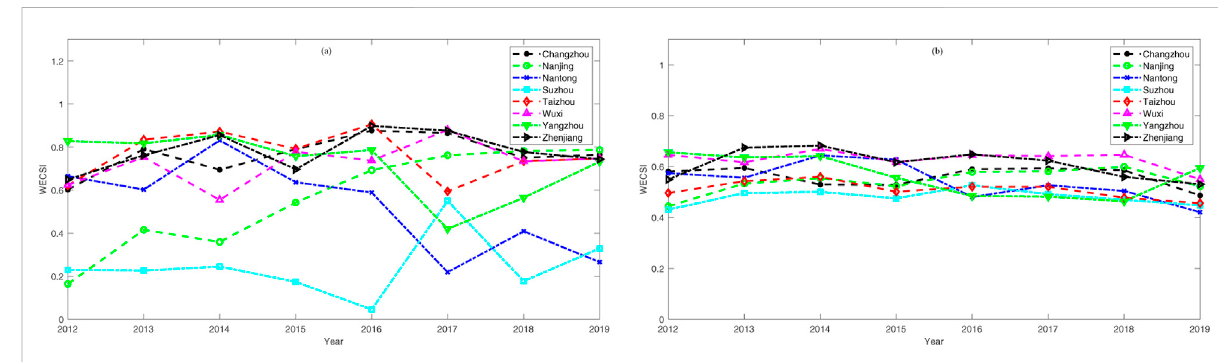
FIGURE 5 The variation of water environment carrying status from horizontal year view based on the projection pursuit (A) and EW method (B)